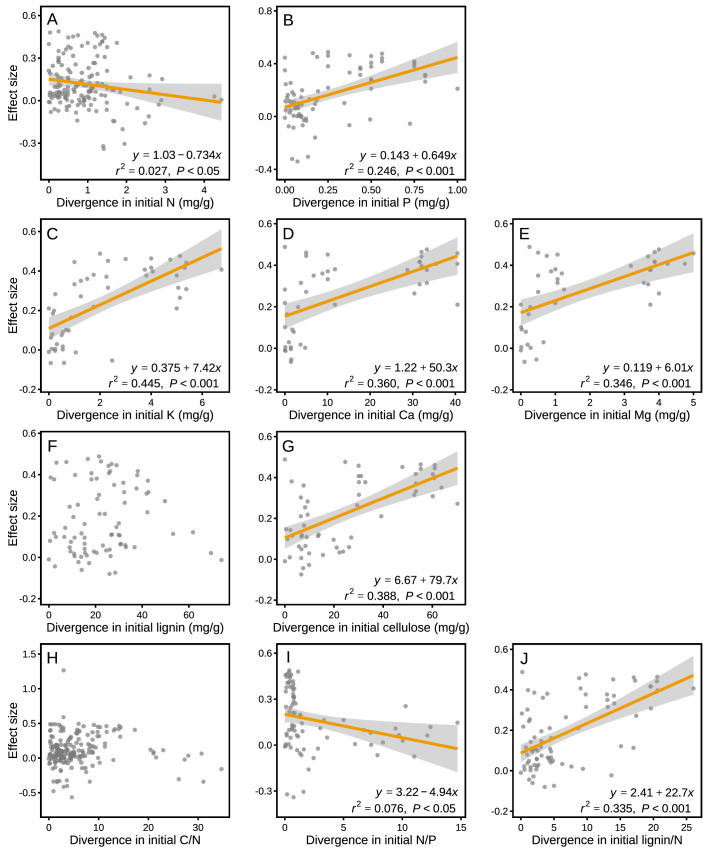
Litter mixture effects on mass loss (effect size) as a function of the divergence in initial litter quality among component litter species in a mixture.Trait divergence was calculated following Rao’s quadratic entropy (see Equation 3) and the Euclidean distance (see Equation 4). The mixture effects represent the data for the decomposition process between 10% and 40% of mass loss, during which the strongest non-additive effects were observed (see Figure 3). The correlations remained significant for Ca (r2 = 0.319, p=0.001) and Mg (r2 = 0.368, p=0.001) even without the data points clustered on the right of the graphs.